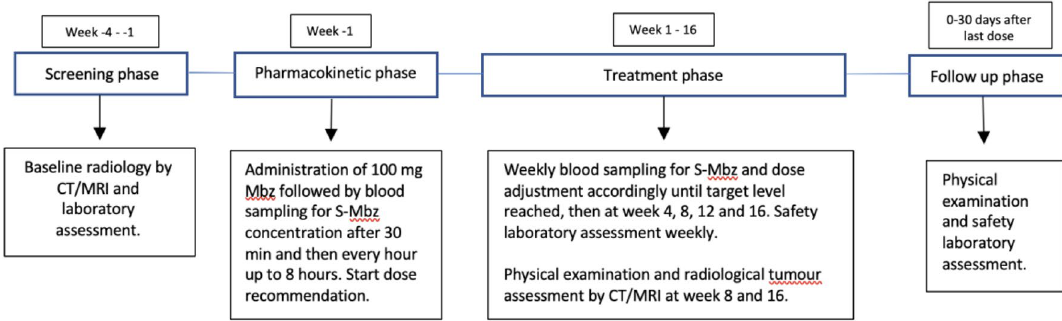
Figure 1. Flow chart of the study procedures. CT computerized tomography, Mbz mebendazole, MRI magnetic resonance imaging, S